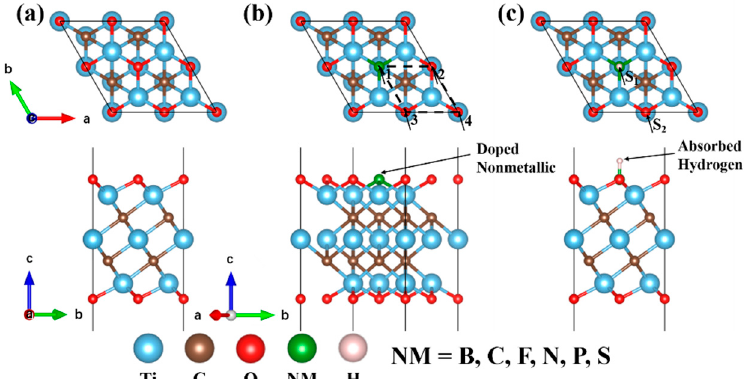
Figure 1. Computational 2 × 2 supercell 2D MXene models. The top one is the top view, and the bottom one is the side view. ( a ) Ti 3 C 2 O 2 2 × 2 supercell. ( b ) Nonmetal doped Ti 3 C 2 O 2 2 × 2 supercell; 1, 2, 3 and 4 represent 4 types surface equivalent doping positions. ( c ) H atom adsorbed on nonmetal doped Ti 3 C 2 O 2 2 × 2 supercell. S 1 represent H adsorbed on the doping atom, S 2 represent H adsorbed on the O atom.